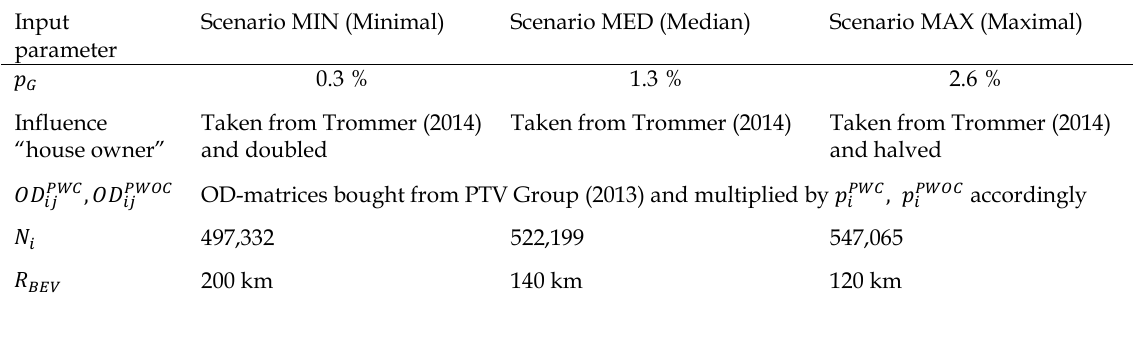
Table 3. Explicit assumptions for the base